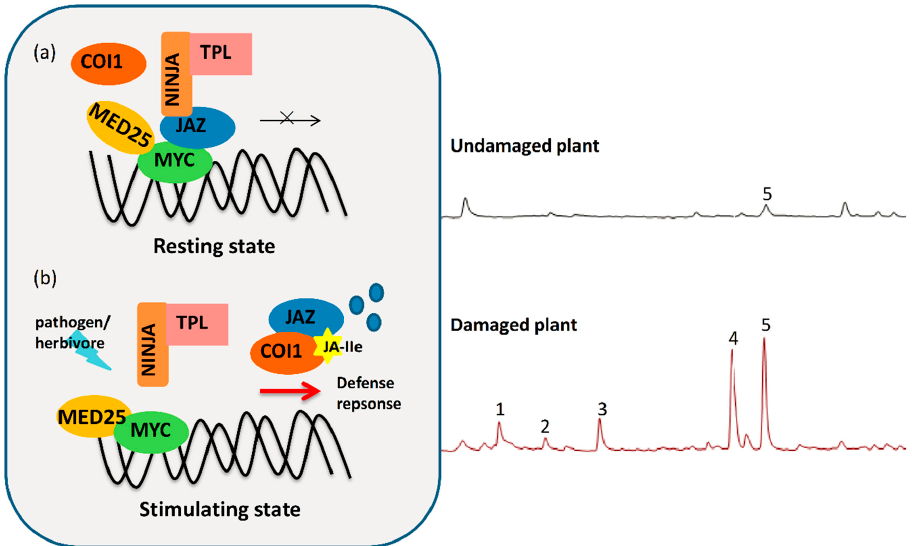
Figure 1. Jasmonate (JA)-mediated defense against plant biotic stresses. ( a ) In resting undamaged cells, JASMONATE ZIM (JAZ) repressor proteins bind with positive transcriptional factors, such as basic helix-loop-helix MYCs. Together with the adaptor protein NOVEL INTERACTOR OF JAZ (NINJA) and the corepressor TOPLESS (TPL) recruited by NINJA, to prevent the activation of the JA pathway. ( b ) When plants are attacked by pathogens or herbivores, the JA signaling pathway can be activated to counter the biotic stress. In a stimulated state, the F-box protein CORONATINE INSENSITIVE1 (COI1) receptor receives the jasmonic acid-isoleucine (JA-Ile) signal and then degrades the JAZ repressor through the E3 ubiquitin-ligase SKP1-Cullin-F-box complex. Once the transcriptional activators, such as MYC proteins, are released, the JA-mediated defense pathway is activated. The plant’s defensive responses will then output a series of defense responses. Plants elicit the induced chemical compounds when damaged by herbivores. The ion chromatograms shown in the right panel indicate the herbivore-induced plant volatiles (HIPVs) emitted from the headspaces of peppers ( Capsicum annuum L.). Peppers that were infested with (lower panel) or without (upper panel) non-viruliferous western flower thrip for 24 h are also shown. The numbered peaks represent (1) 3-hexen-1-ol acetate; (2) D-limonene; (3) beta-ocimene; (4) beta-linalool; (5)